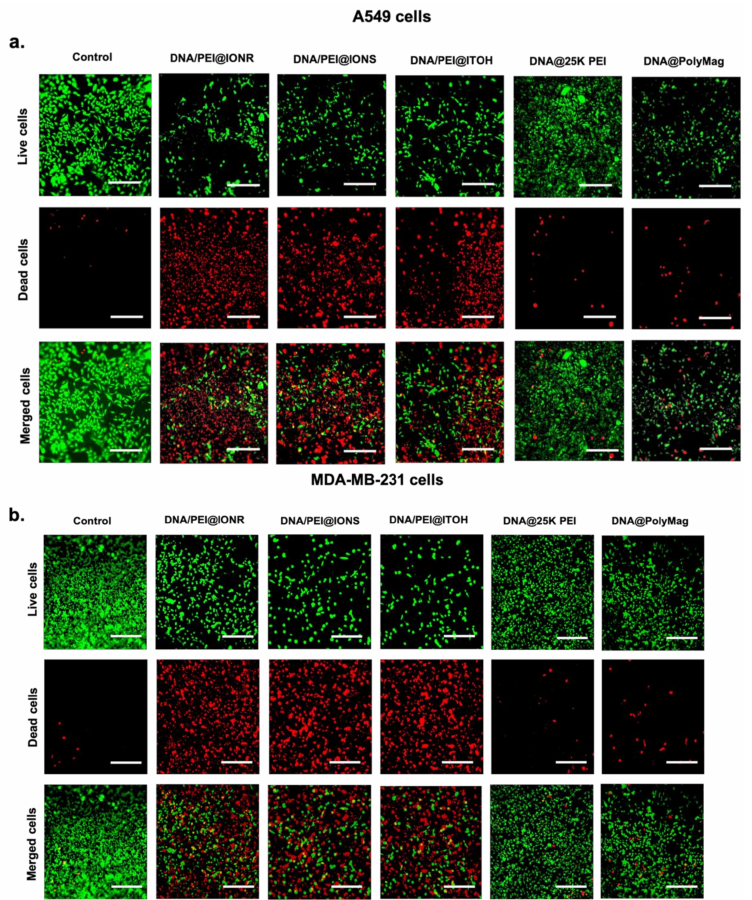
Figure 5. Live/dead cell staining. ( a ) A549 and ( b ) MDA-MB-231 cells transfected with miRNA34a and incubated for 48 hours. Post-transfection cells were stained with calcein-AM/PI staining solution and images were captured using a fluorescence microscope. Scale bar: 100 µ m. Cells stained in green indicate live cells and cells stained in red indicate dead cells, probably undergoing apoptosis after transfection. In contrast, cells treated with PEI 25K and PolyMag showed higher cytotoxicity, which caused surface detachment during the staining process after washing with phosphate-buffered saline (PBS), leading to cell